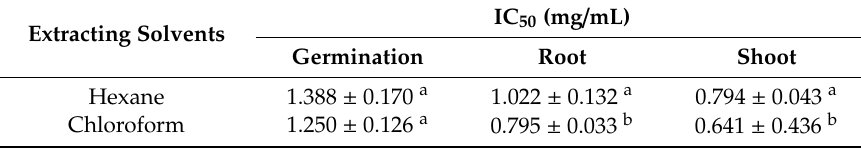
Table 1. Inhibition of di ff erent extracts of C. militaris on germination and growth of radish. Extracting